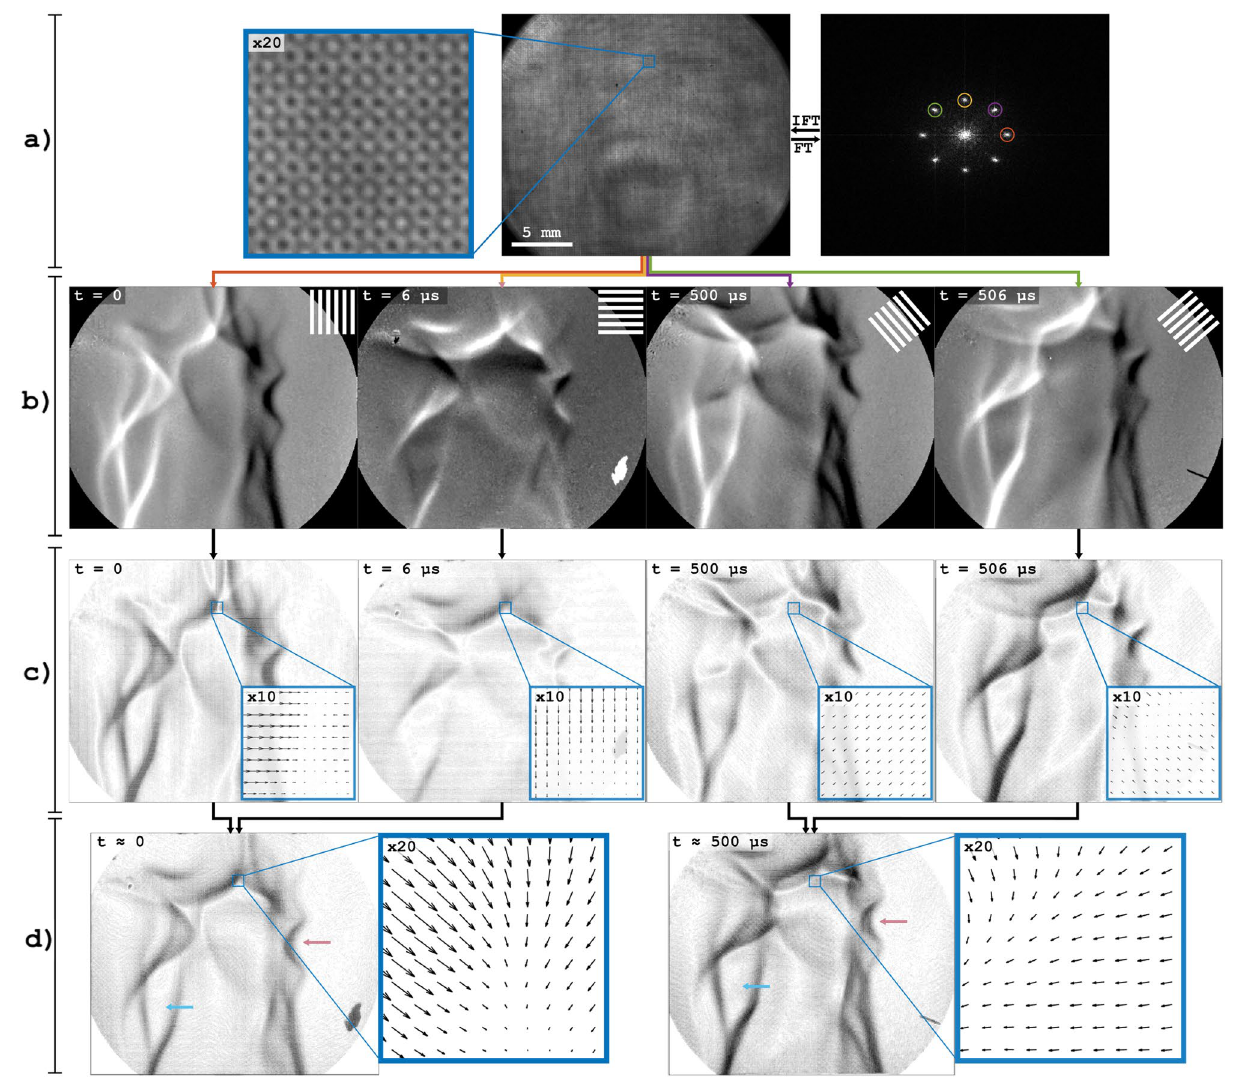
Figure 7. Videography using orthogonal modulations. ( a ) The original image and the absolute value of its Fourier transform. ( b ) Images showing the magnitude of the flame induced displacement. ( c ) Magnitude and direction of the displacement, shown through arrow plots. ( d ) The displacement vectors of both signal pairs, i.e. signals recorded with the minimum possible temporal separation of 6 μs, are added to get the full 2D vector displacement at both recording instances. The red and blue arrows point at (what is considered) identical structures in the flame. The zoomed in sections are of identical